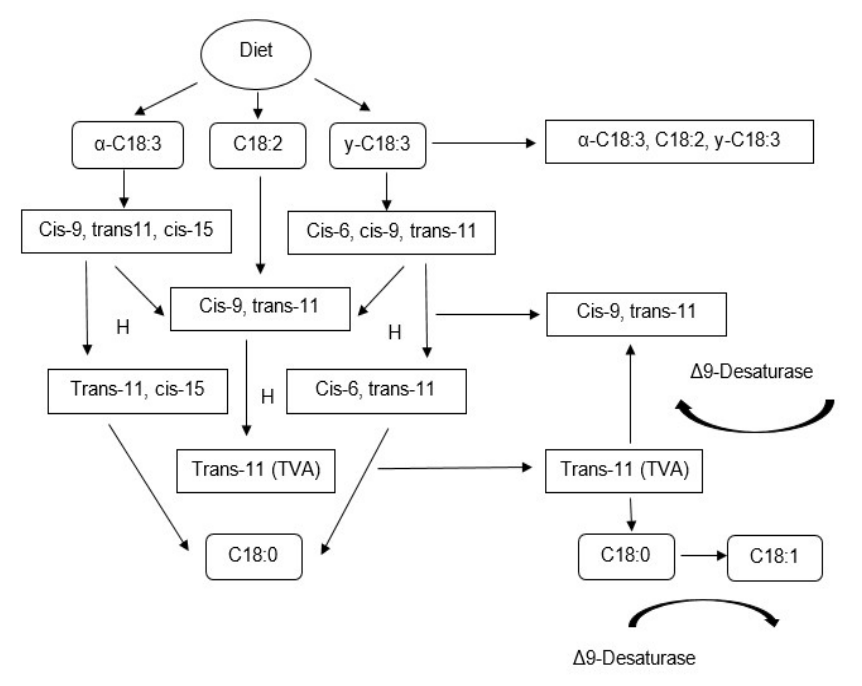
Figure 2. Synthesis of conjugated linoleic acid in ruminants [26].